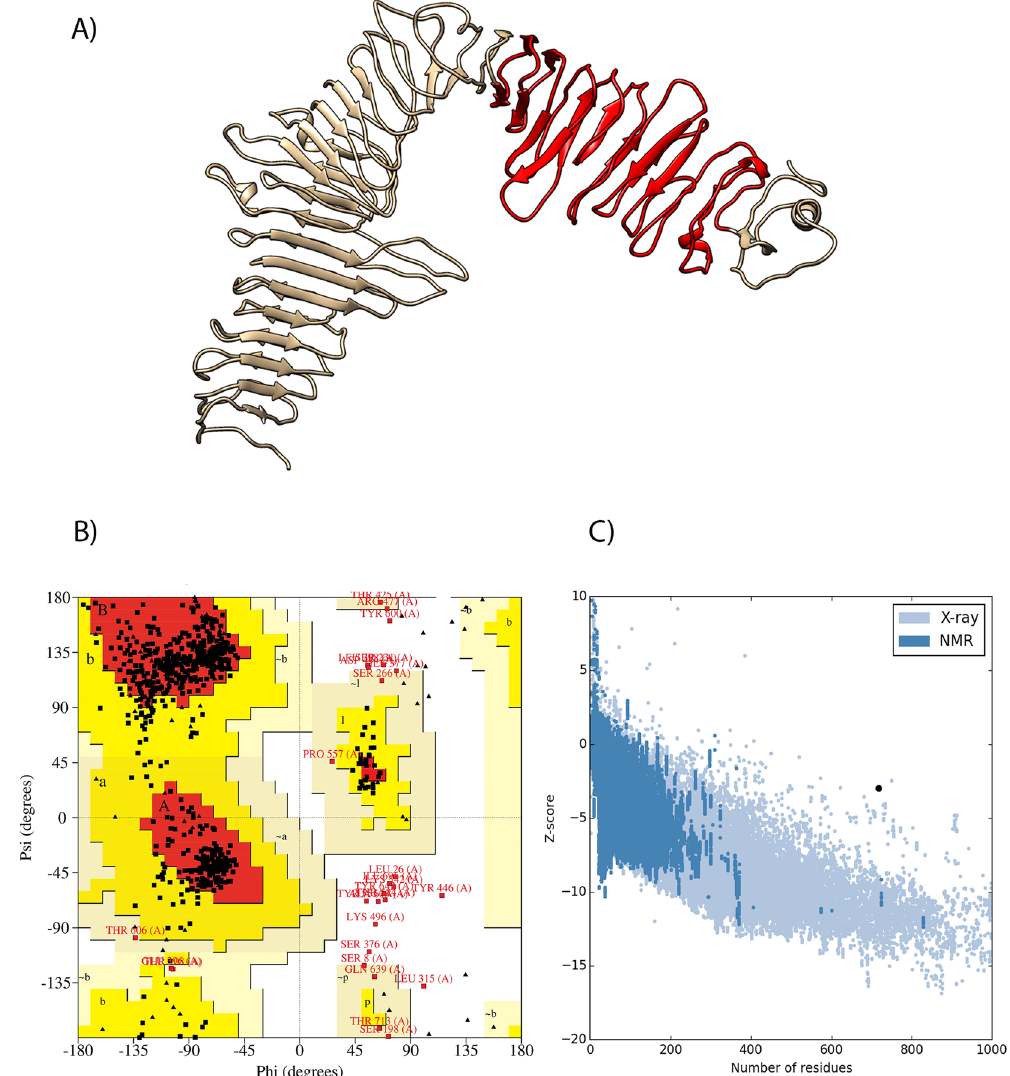
Figure 2. Predicted three-dimensional structure and validation of lipoprotein Q75FL0. ( A ) Three dimensional structure of the predicted model with the domain (LurC domain shown in red colour). ( B ) Ramachandran plot of refined 3D model showing 80.3%, 15.4%, 1.8% and 2.5% residues in the most favoured, additional allowed, generously allowed and disallowed region respectively. ( C ) Z-Score plot for 3D structure of model showing −